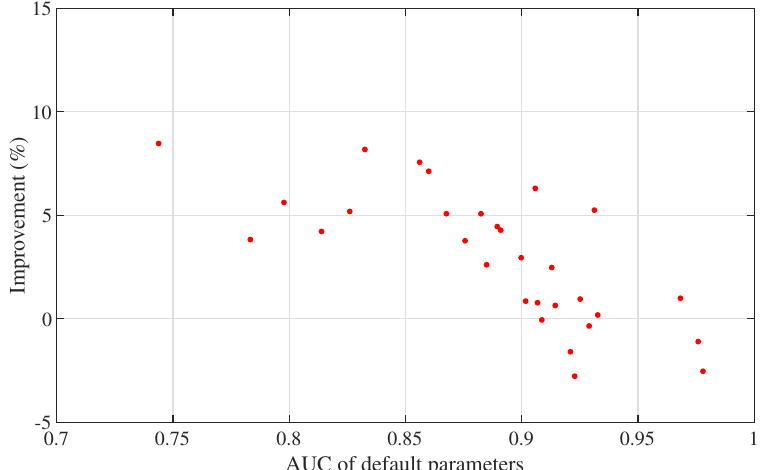
Figure 8. Cross-validation on test data